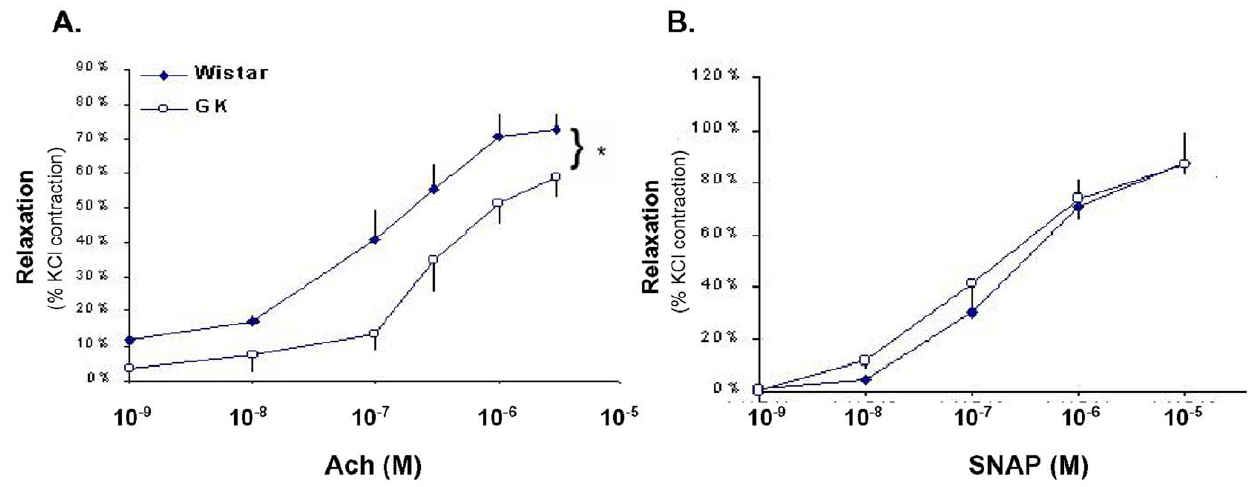
Figure 2. Vasorelaxation of small arteries ( , 150 m m) from 9 month-old GK or Wistar rats is endothelia dependent. A. Diabetes significantly decreased acetylcholine-induced dilation ( $ 10 2 6 mol/L) in GK compared to Wistar. B. Diabetes did not alter the response to SNAP (a nitric oxide donor). Values are mean 6 SEM of 4 animals. * p , .05 compared to Wistar. doi:10.1371/journal.pone.0011800.g002 PLoS ONE |